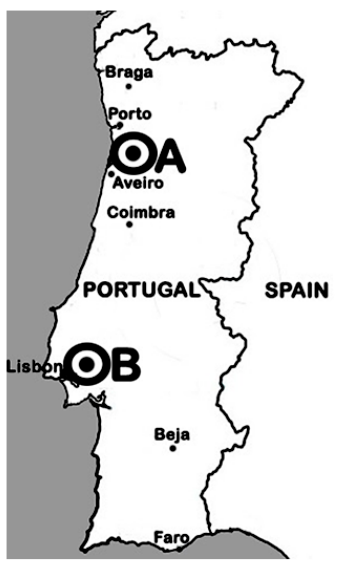
Figure 1. Map location of the sampling sites (A and B).